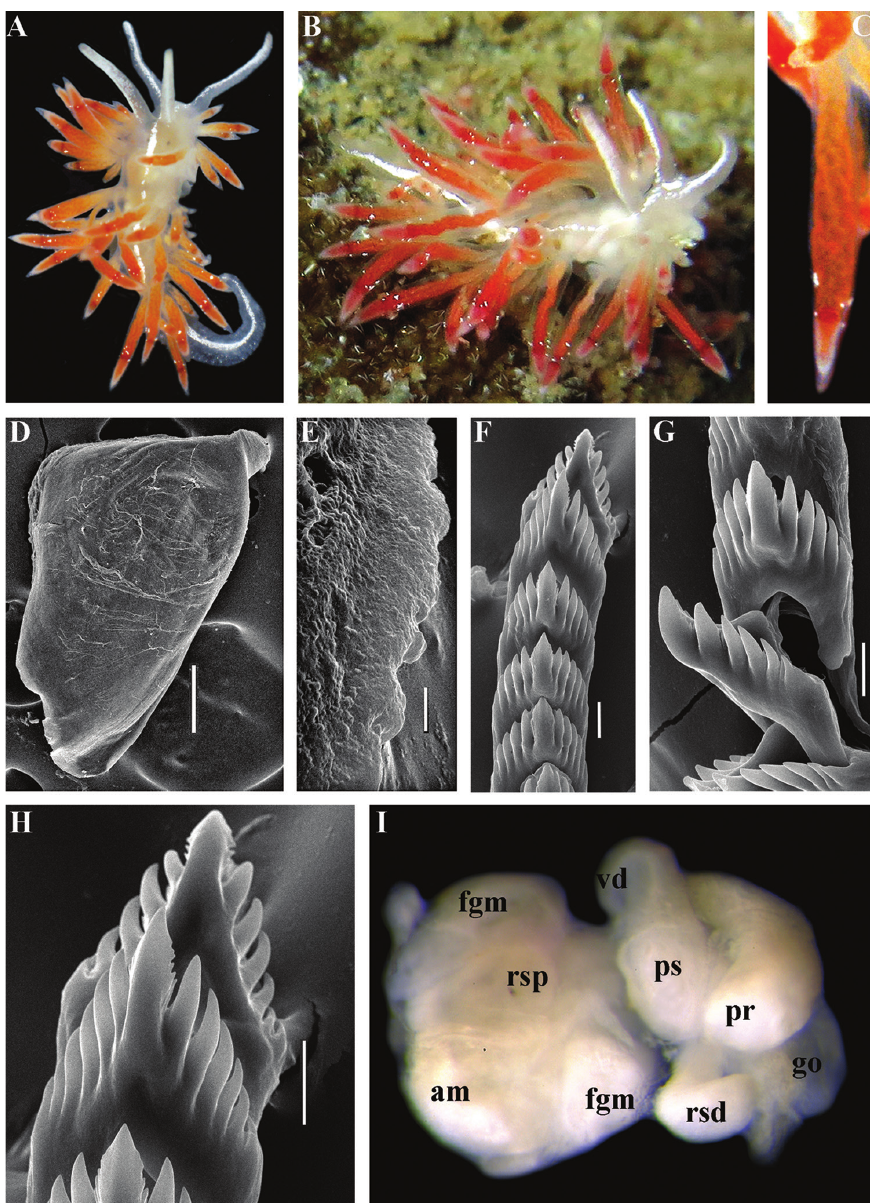
Figure 41. Pacifia amica sp. n., NE Pacific, Port Orchard, holotype ZMMU Op-614: A live, dorsal view, 6.5 mm in length B lateral view C details of cerata D jaws, lateral view E details of masticatory processes of jaw F posterior rows of radula, SEM G anterior rows of radula H details of posterior radular teeth I reproduc- tive system in situ, light microscopy. Abbreviations: am ampulla fgm female gland mass go genital opening pr prostate ps penial sheath rsd distal receptaculum seminis rsp proximal receptaculum seminis vd vas deferens. Scale bars: D = 100 μm E =2 μm; F, G, H = 10 μm. Photos of living specimens by K. Fletcher, other photos and SEM images by A.V.